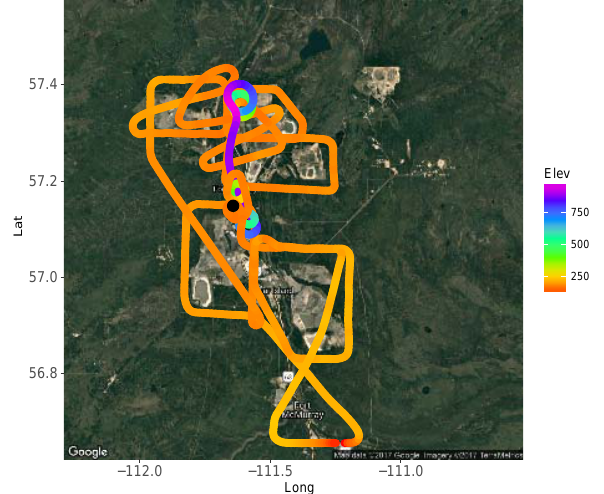
Figure 3. Flight path on 13 August 2013, where elevation (in me- tres) is denoted by the colour scale and the AMS13 site is indicated by a black